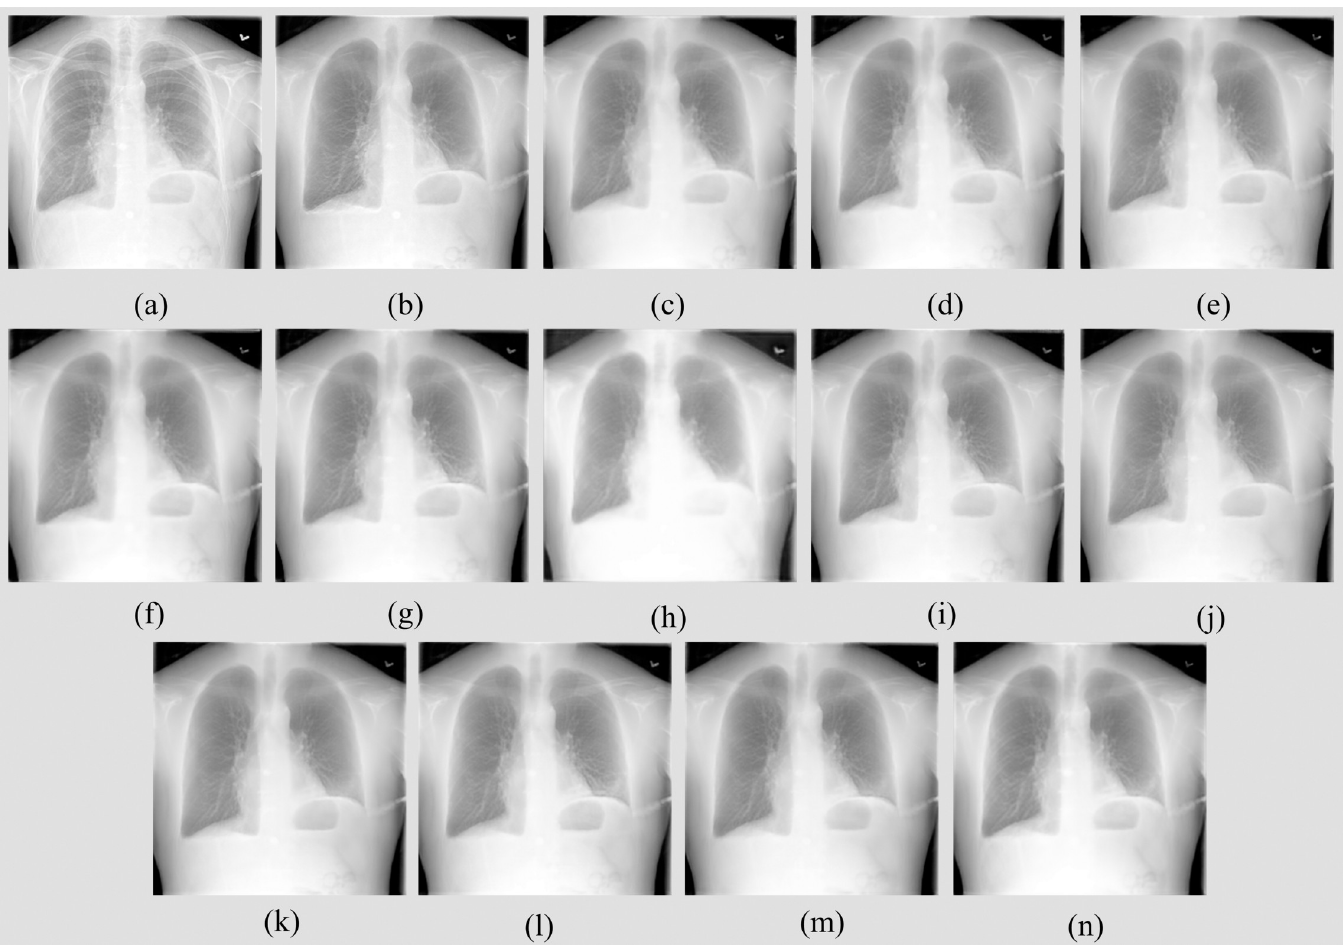
Fig 6. Bone-suppressed CXR images predicted by the proposed models using a CXR sample from the NIH–CC DES-Set 1 test set. (a) Original CXR; (b) Ground truth soft tissue image; (c) U-EB0-BS; (d) U-Res18-BS; (e) U-SE-Res18-BS; (f) U-D121-BS; (g) U-IV3-BS; (h) U-MobileV2-BS; (i) F-EB0-BS; (j) F-Res18-BS; (k) F-SE-Res18-BS; (l) F-D121-BS; (m) F-IV3-BS and (n)